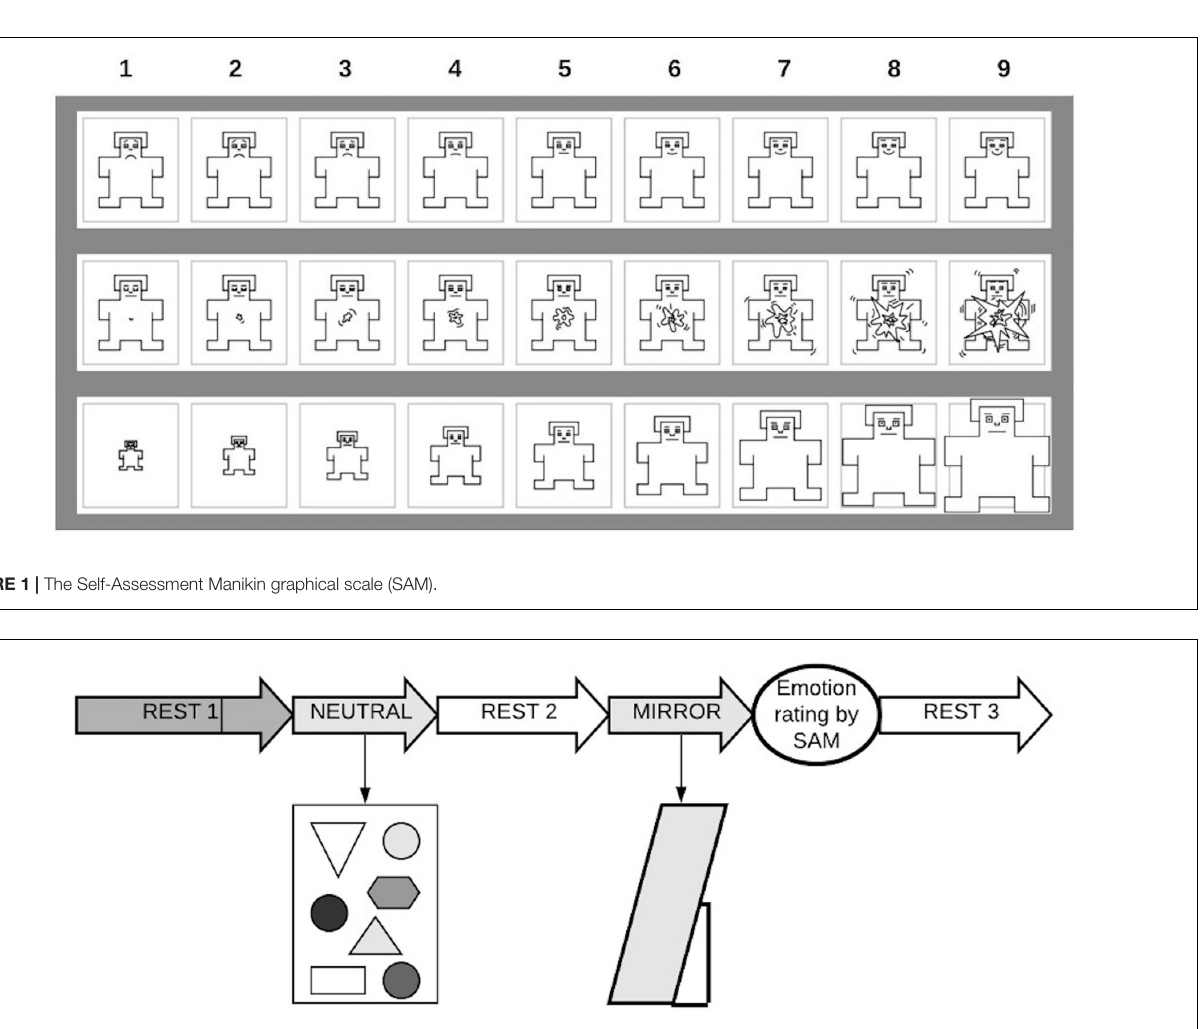
SE s. Spearman correlation coefficients were used for the